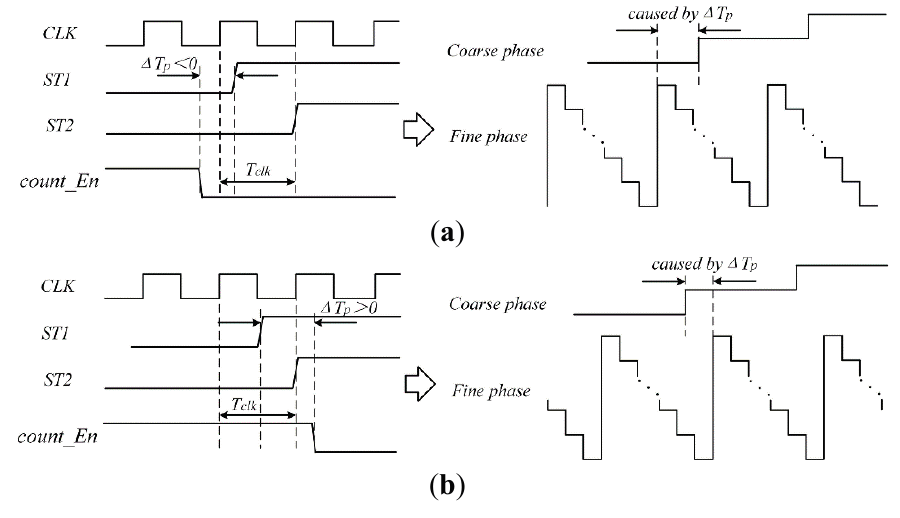
Figure 9. Timing diagrams of the TDC illustrating quantization error sources. ( a ) Δ T p < 0; ( b ) Δ T p >